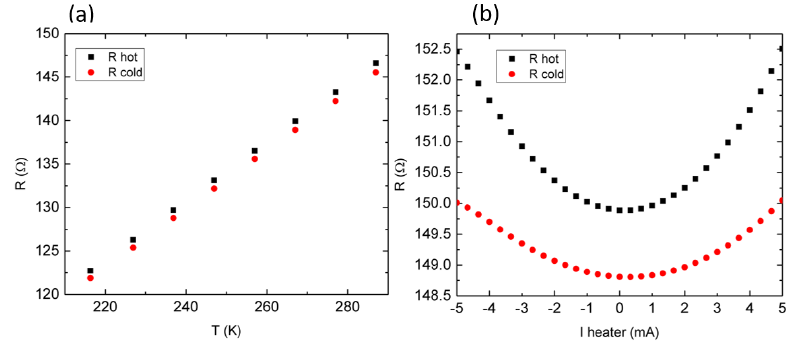
Figure 10. ( a ) Thermometers’ “hot” and “cold” electrodes’ calibration. ( b ) Thermometers’ resistance evolution with respect to the current applied to the microheater, at room